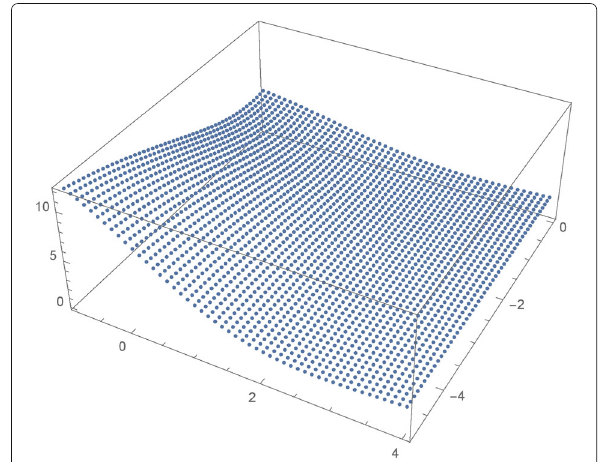
Fig. 18 Variance of the procurement cost V [ C ]